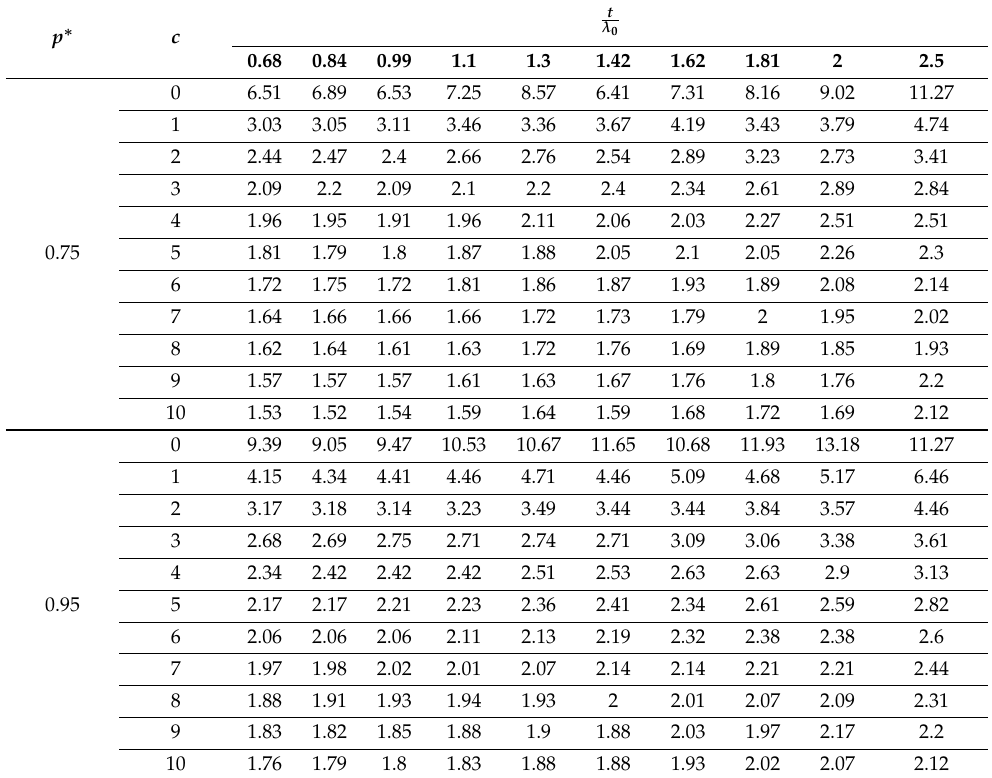
Table 7. Minimum values of λ required for acceptability of a lot with producer’s risk of 0.05 for λ 0